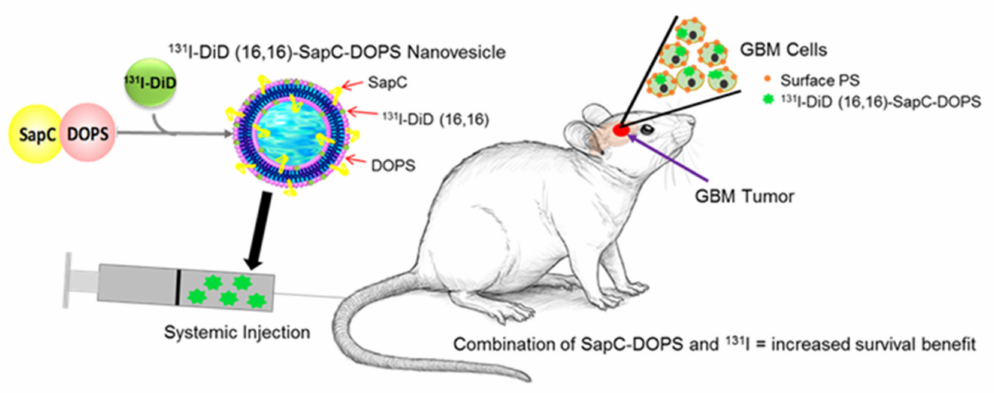
Figure 7. 131 I-DiD (16,16)-SapC-DOPS increases GBM-bearing mouse survival. SapC-DOPS was prepared with the radioiodinated phenolic compound DiD (16,16). The resulting modality was injected into mice bearing a GBM. We propose that the radiation from the 131 I kills tumor cells with low surface phosphatidylserine (PS) while the SapC-DOPS kills predominately tumor cells with higher surface PS; thus there is an enhancement in treatment of the